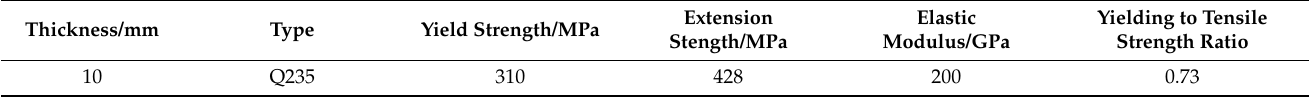
Table 1. Mechanical parameters of steel plate.